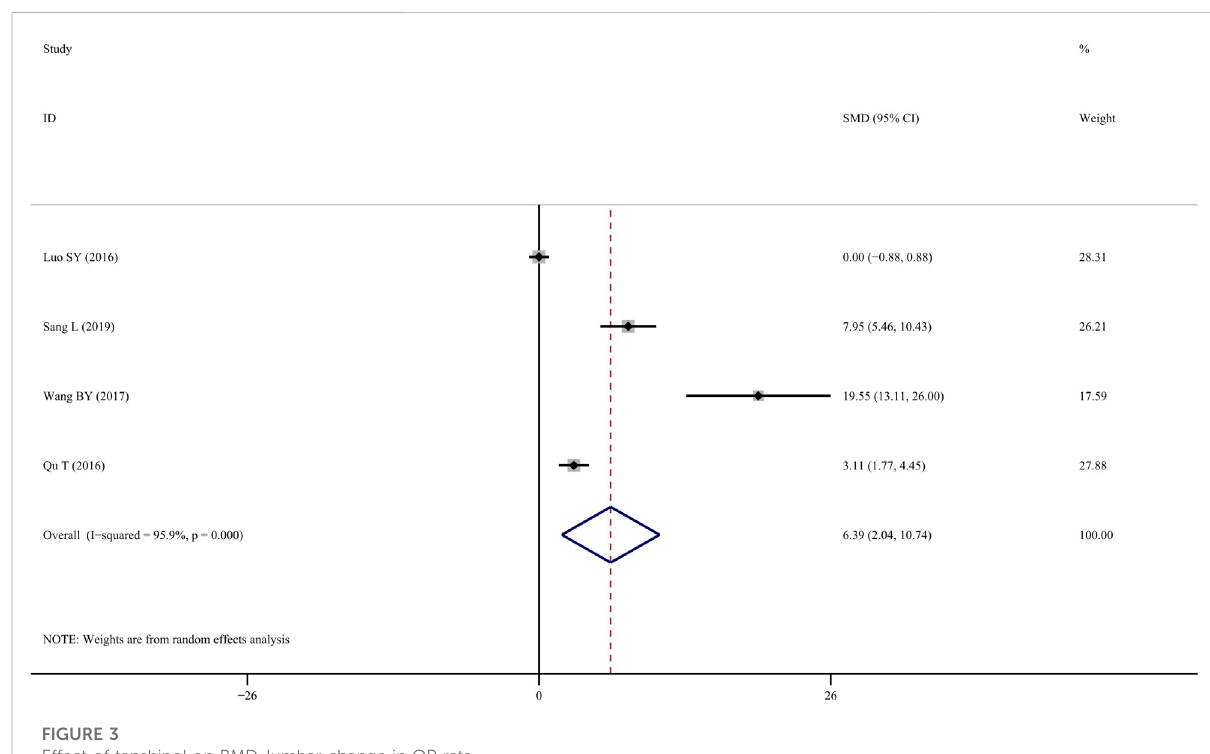
FIGURE 3 Effect of tanshinol on BMD-lumbar change in OP